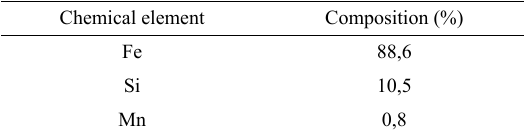
Table 1: Chemical composition of iron ore fine obtained from EDX analysis.